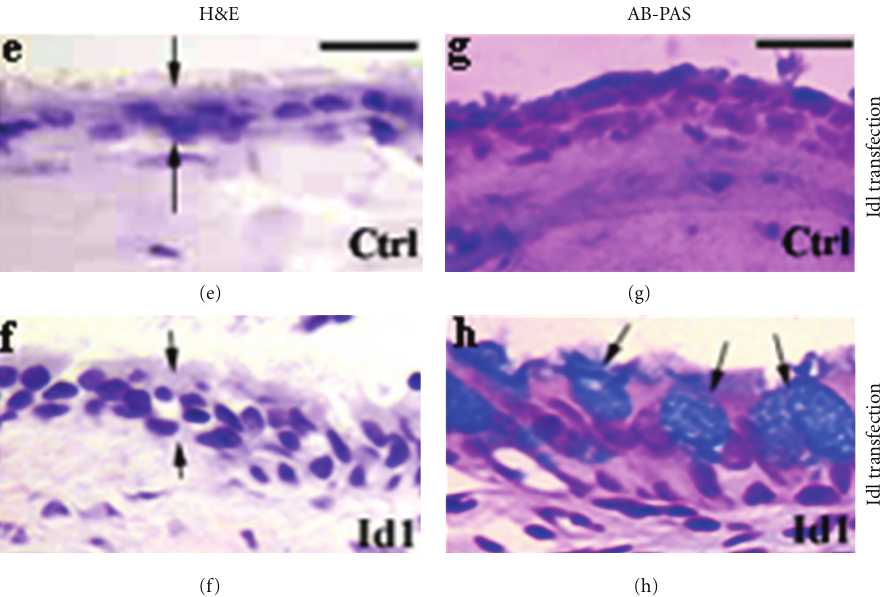
Figure 8: Id1 induces the proliferation of middle ear epithelial cells ((f), H&E stain) and mucous cells (arrows, (h), AB-PAS stain) compared with empty vector controls ((e), H&E, (g), AB-PAS). Note that the thickening of the middle ear epithelium is increased in Id1-transfected animals ((f), between arrows) compared with empty vector-transfected controls (e).